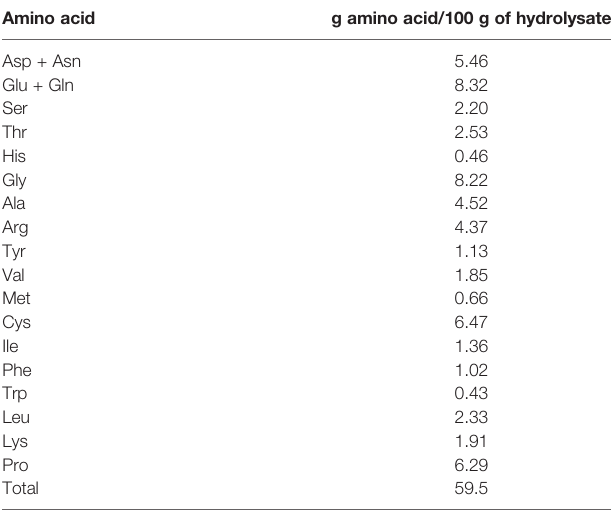
TABLE 6 | The composition of amino acid in sea cucumber hydrolysate with papain hydrolysis. Amino acid g amino acid/100 g of